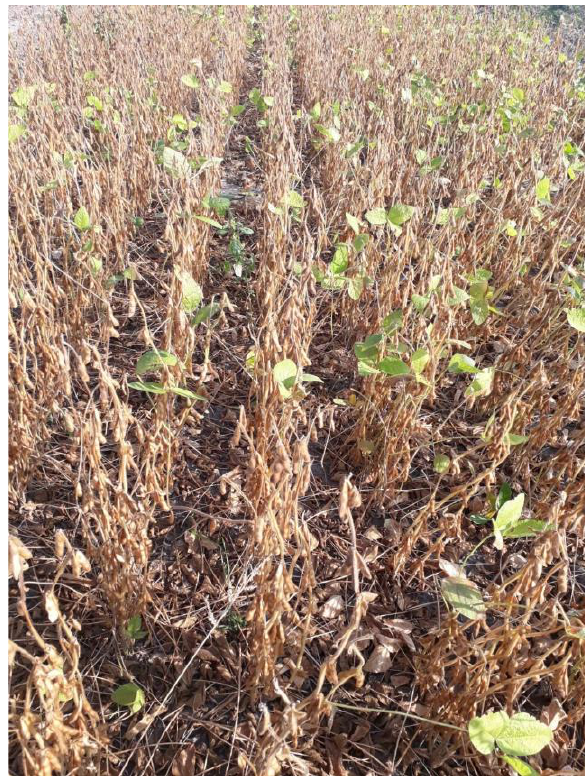
Figure 2. Soybeans at harvest stage BBCH 89.